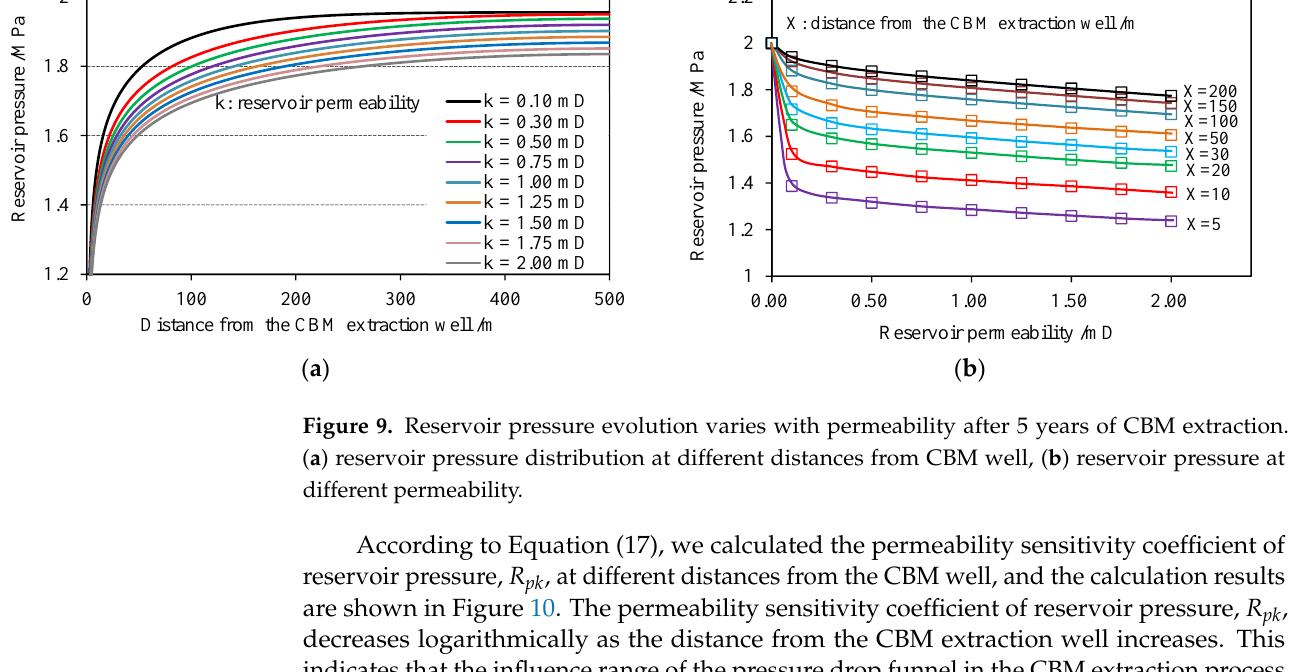
Figure 10. R pk at different distances from the CBM well. 4.3. Influence of a Hydraulic Fracture The reservoir pressure for different hydraulic fracture morphologies is calculated, and those on profile line 1 (see Figure 7) after 5 years are shown in Figure 11, and those on profile line 2 are shown in Figure 12. The reservoir pressure drop of CBM exploitation with hydraulic fractures is much higher than that without hydraulic fractures, indicating that the effect of hydraulic fracturing is significant. With the increase in the hydraulic frac- ture length, the reservoir pressure drops after the CBM being extracted for the same time increases. The pressure drop difference along the fracture length is more significant than that perpendicular to the fracture.